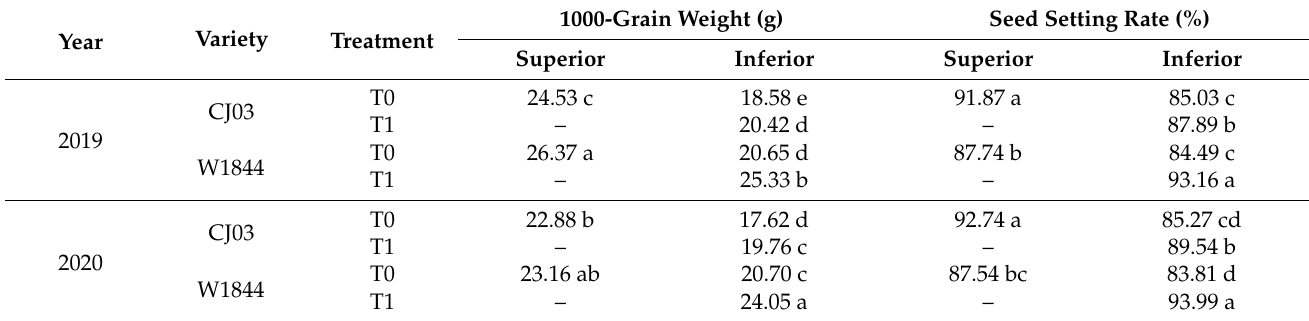
Table 2. 1000-grain weight and seed setting rate of rice materials at